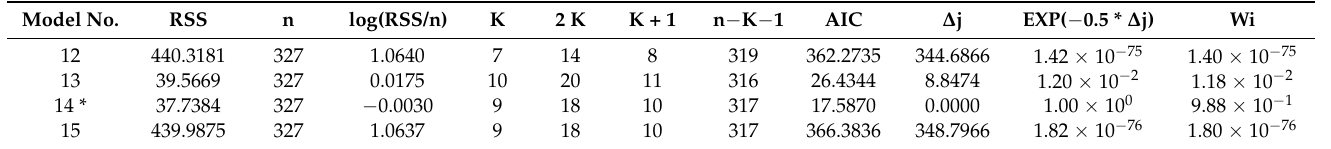
Table 3. Results of the inter-model comparison using the Akaike Information Criteria for soil erosion regression models using the landscape PLAND metric. Model